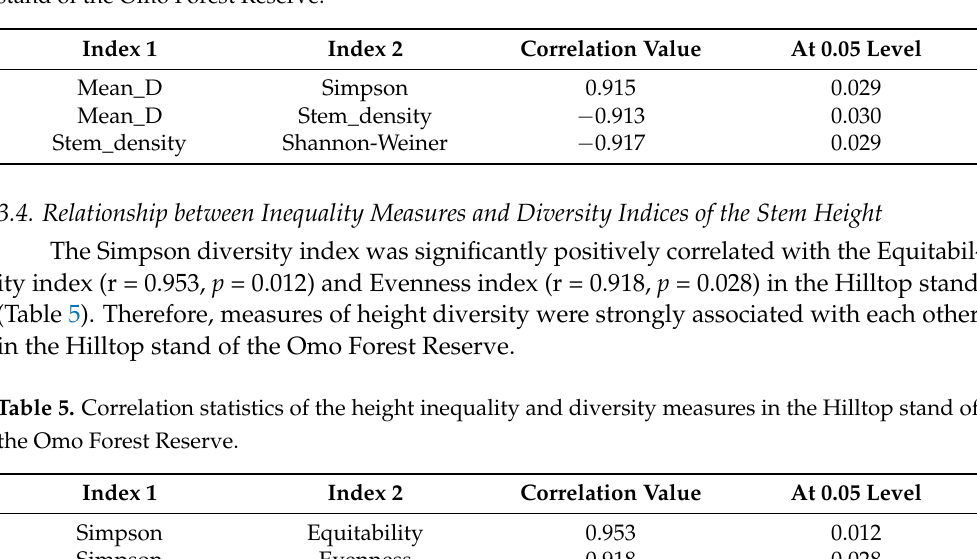
Table 4. Correlation statistics of the diameter inequality and diversity measures in the Valley-Bottom stand of the Omo Forest Reserve.